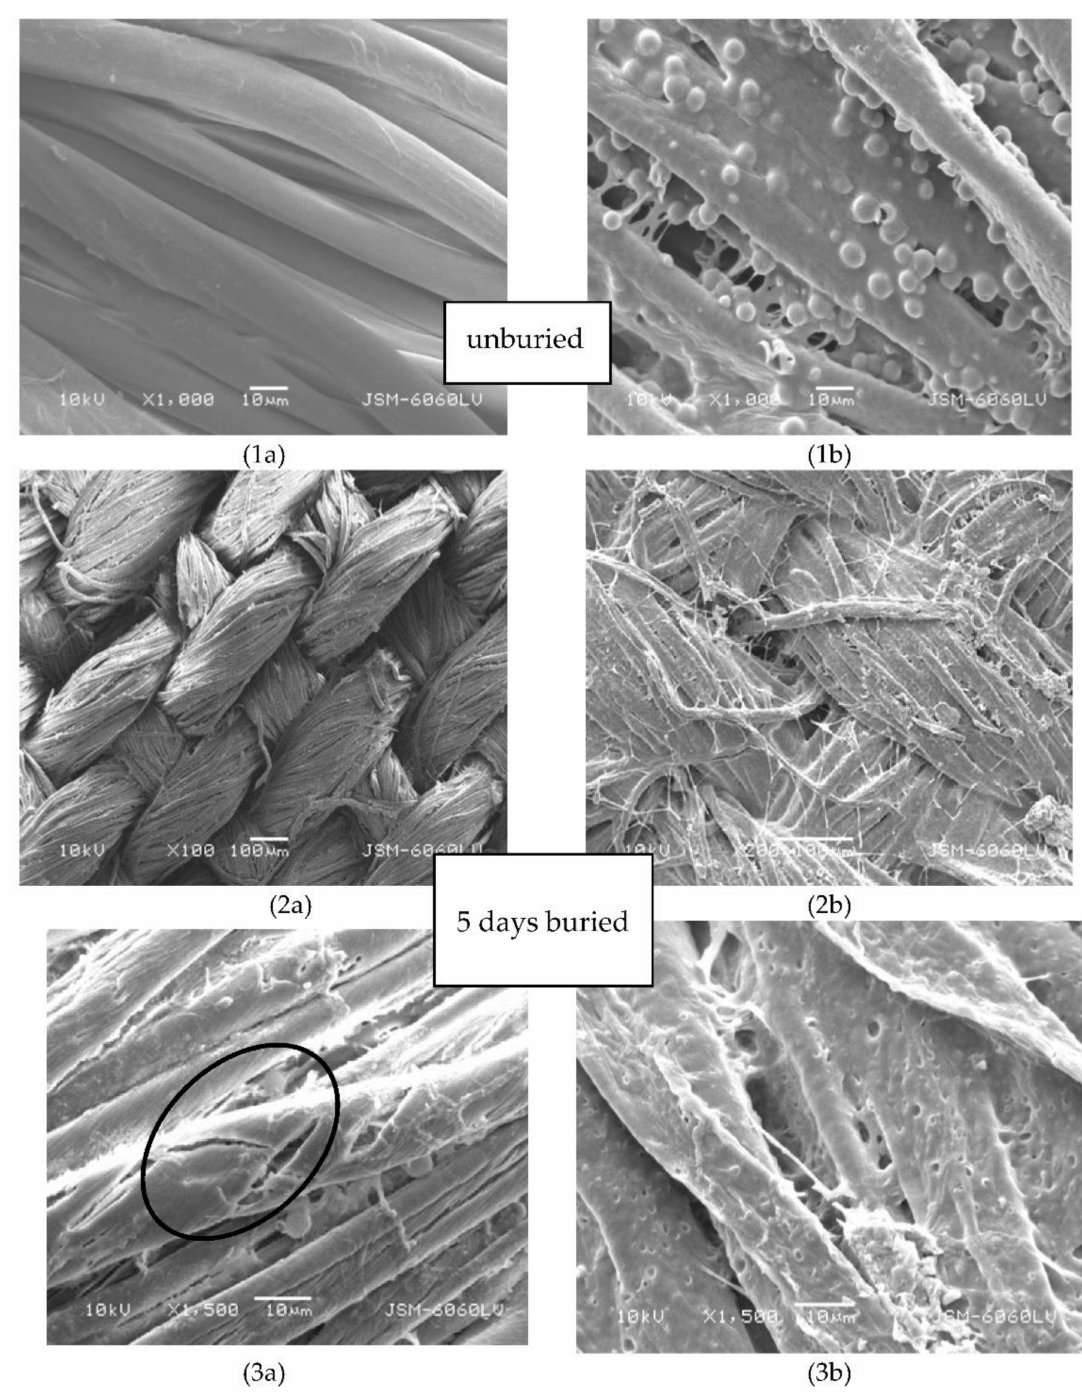
Figure 9. SEM micrographs of unburied and 5 days buried cotton fabric; unprinted ( 1a – 3a ); fully printed ( 1b – 3b